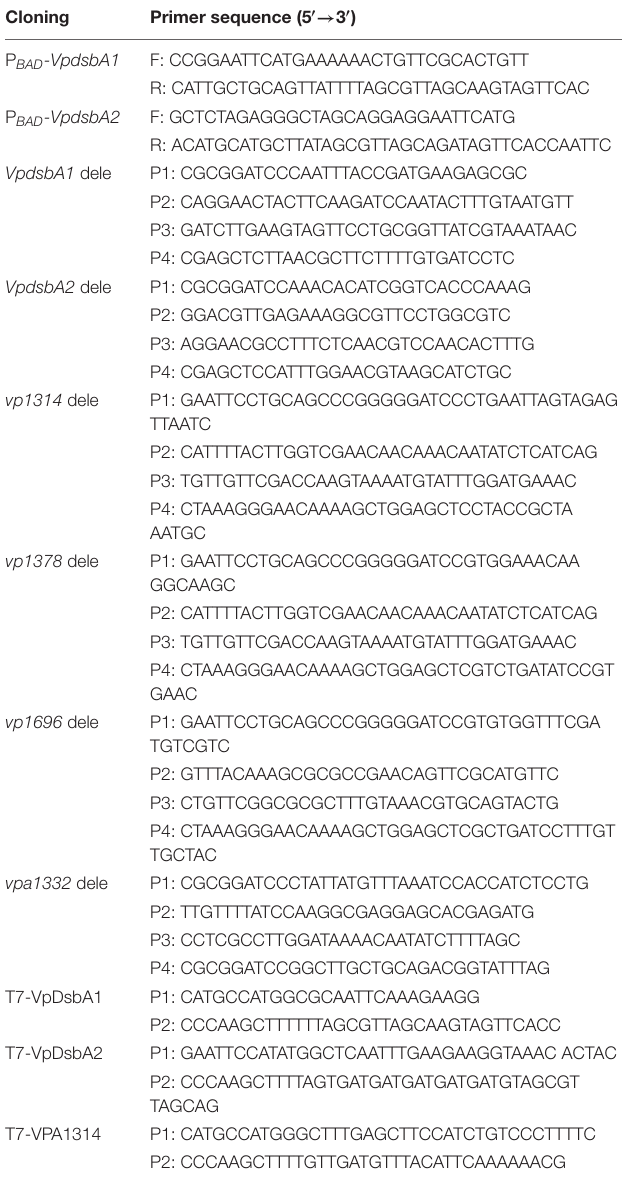
TABLE 2 | Primer sequences used for cloning in this study.